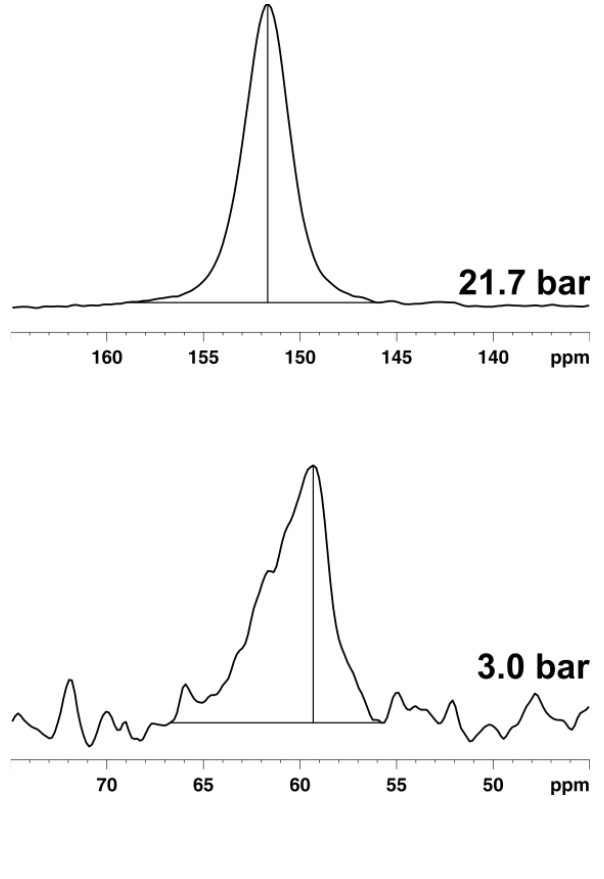
Figure 11. 129 Xe NMR signals of Xe@UMCM-1 measured at RT and different